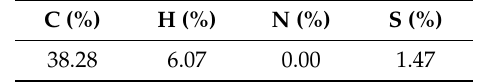
Table 1. Percentages of the content of C, H, N, and S for the sulfonated derivative.